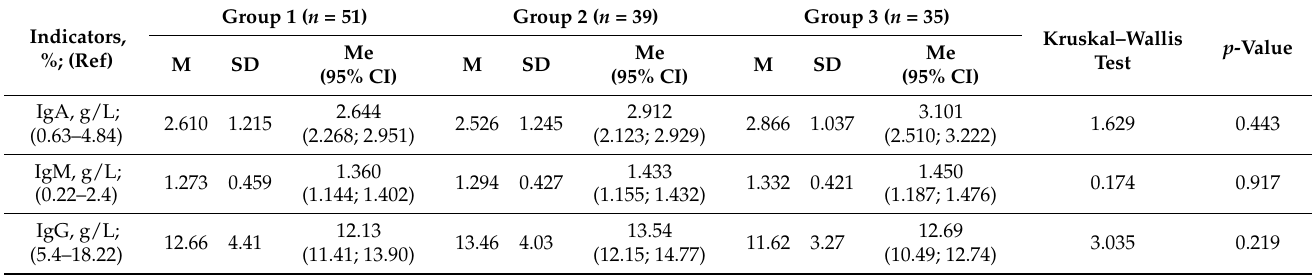
Table 3. Indicators of humoral immunity of workers of three groups in chrysotile asbestos